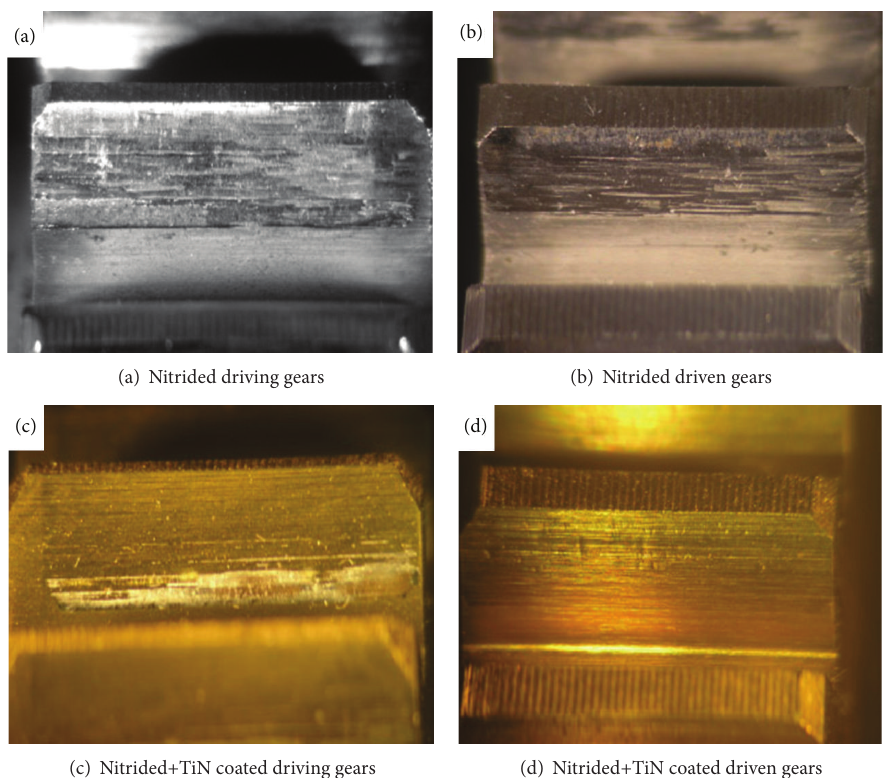
Figure 3: The macrophotograph of tooth surface after running